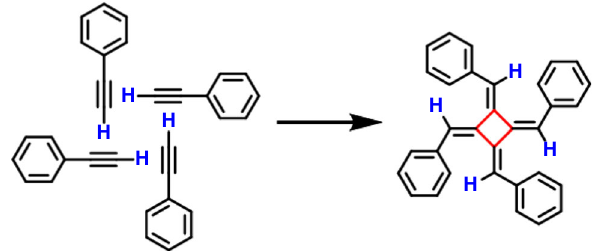
Fig. 1 The [1 + 1 + 1 + 1] cyclotetramerization reaction of self-assembled alkyne groups. The one-step synthesis of tetraphenyl[4]radialenes via a novel [1 + 1 + 1 + 1] cyclotetramerization reaction pathway on the Cu(100)